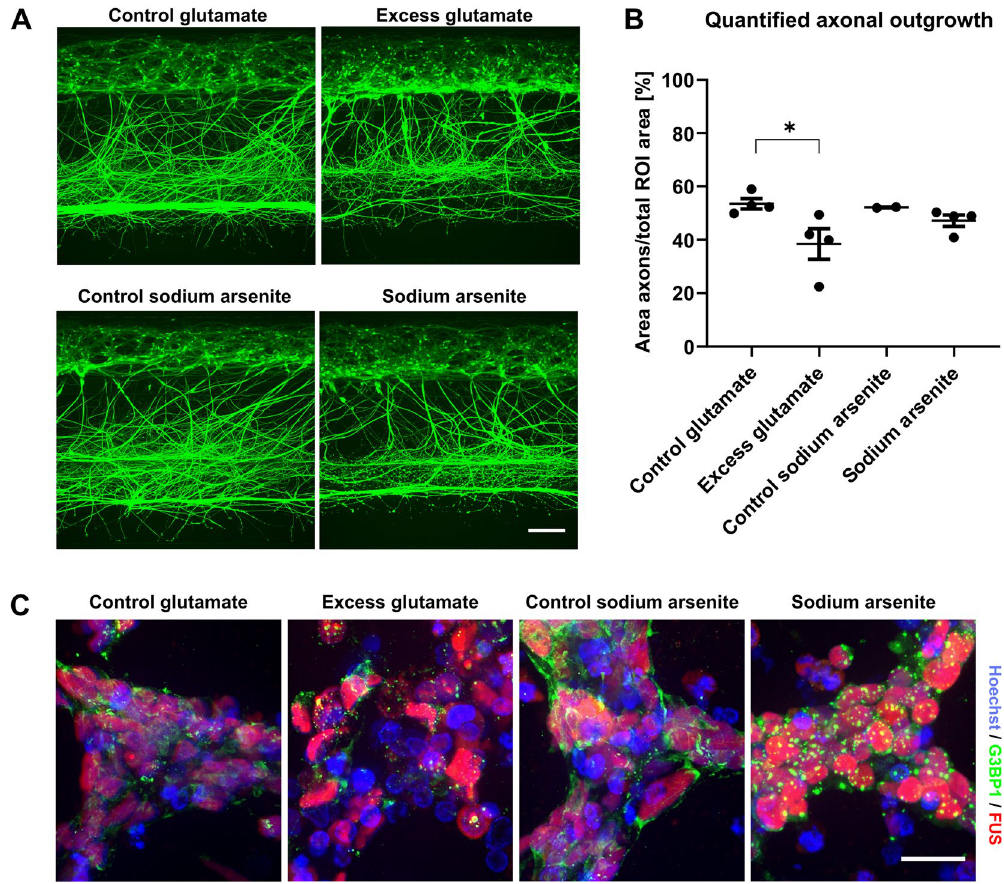
Figure 5. Excitotoxic conditions induce reduced axon outgrowth and formation of stress granules. ( A ) Motor neurons (day 17) were exposed to 5 mM glutamate for 7 days or 0.05 mM sodium arsenite for 3 h and labeled with calcein-AM dye. The scale bar is 200 µm. ( B ) Quantification of the axon outgrowth depicted in ( A ). Graph shows mean ± SEM. n = 2–4, *(P < 0.05); Kruskall-Wallis test. The graphic representation was created using GraphPad Prism, version 8.3.1 (https ://www.graph pad.com/scien tific -softw are/prism /). ( C ) Motor neurons (day 17) grown in an OrganoPlate 2-lane were exposed to 5 mM glutamate for 7 days or 0.05 mM sodium arsenite for 3 h. Cells were immunostained for the stress granule marker G3BP1 (green) and for FUS (red). Maximum projection images, the scale bar is 20